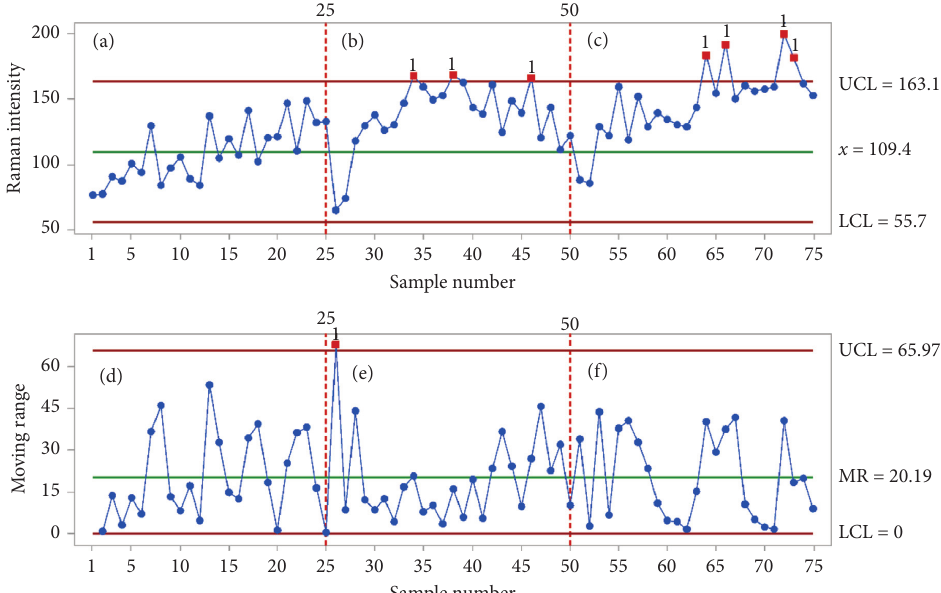
Figure 2: Quality fluctuation individual value of brand XX (a), brand YY (b), and brand ZZ (c) and moving range of brand XX (d), brand YY (e), and brand ZZ (f) based on Raman peak intensities (at 1760cm − 1 ), respectively. UCL � upper control limit; LCL � lower control limit; MR � the average value of moving range control chart. The UCL, LCL, and MR were calculated based on the Raman data of brand